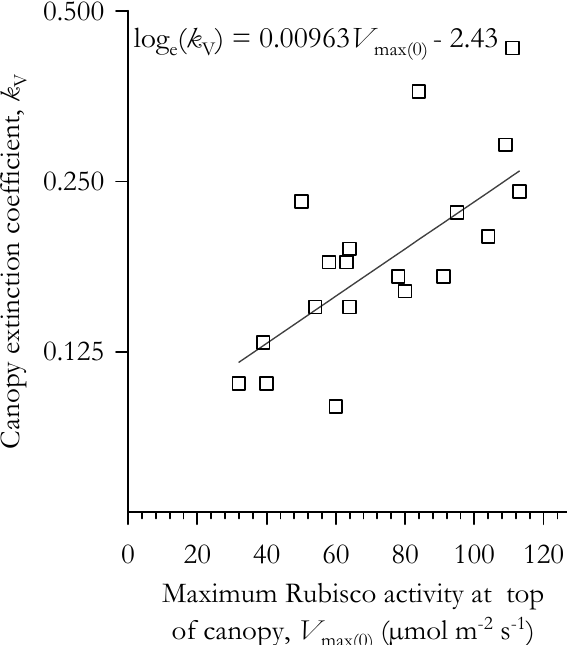
Fig. 10. Relationship between within canopy gradients in activity of ribulose-1,5, bisphosphate carboxylase/oxygenase, Rubisco, and maximum Rubisco activity in upper-canopy leaves for a range of broadleaf forests and/or trees taken from a literature review. Details of the individual studies and means of calculation are given in the Supplementary information. Note the logarithmic scale for k V . Due to uncertainties in the estimates of both the independent and depen- dent variables from this literature survey (see Supplementary infor- mation), the fitted line has been obtained using a high breakpoint rank regression technique (Chang et al., 1999) and is significant at P<